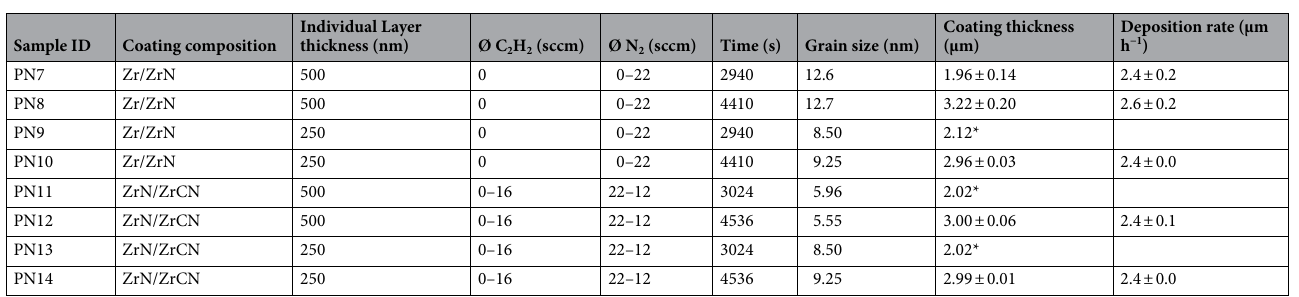
Table 3. Films thicknesses, grain size and deposition rates. *Thicknesses and standard deviation are estimated using deposition rates calculated by means of calotest and SEM images.